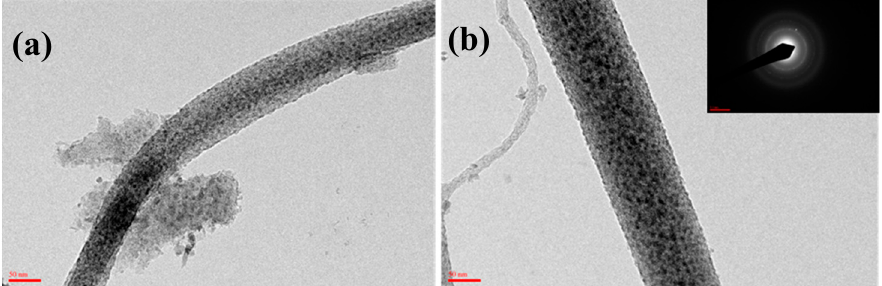
Figure 9. ( a ) TEM images for TiC nanofiber mat after calcination at 1000 °C; ( b ) diffraction pattern.